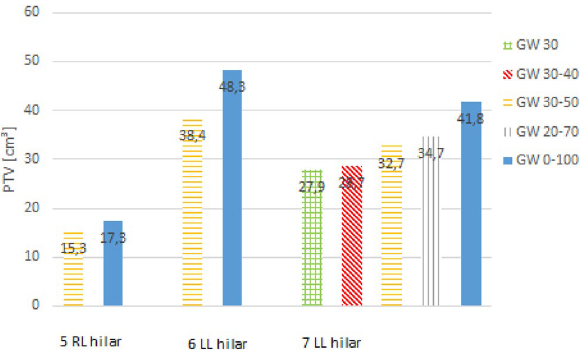
Figure 5. PTV in cm 3 for central tumors for different gating window sizes. The horizontal axis caption refers to the patient case and the location.